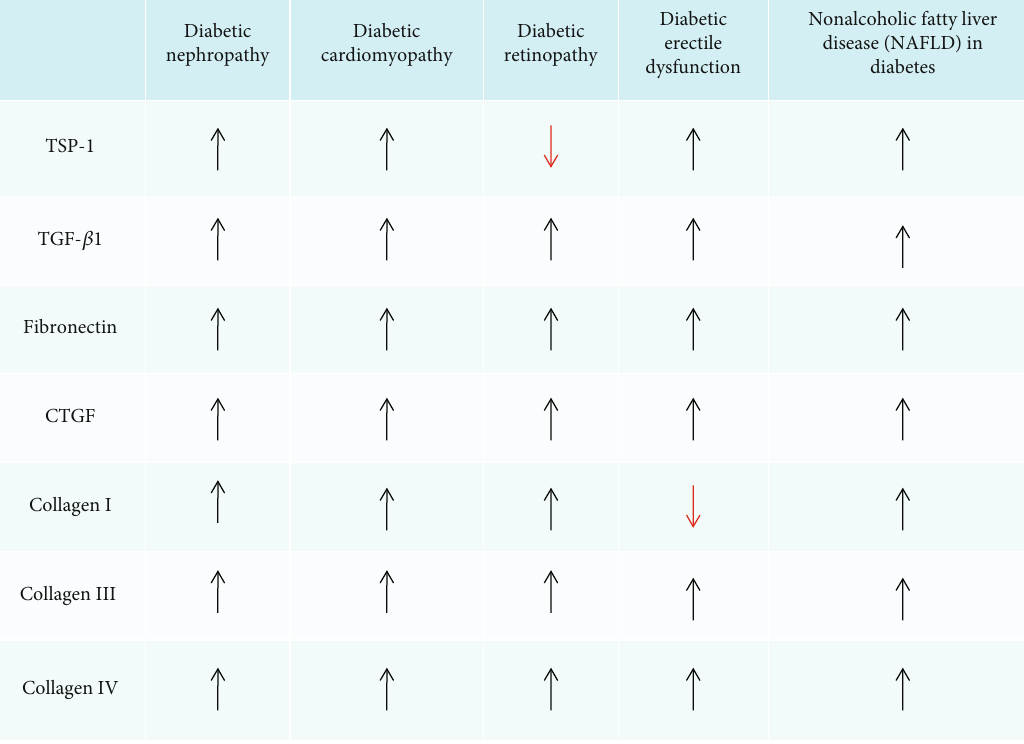
Figure 4: Summary of the expression of TSP-1 and ECM proteins in diabetic complications. TSP-1: thrombospondin-1; TGF- β 1: transforming growth factor β 1; CTGF: connective tissue growth factor; ↑ : increased expression; ↓ : decreased